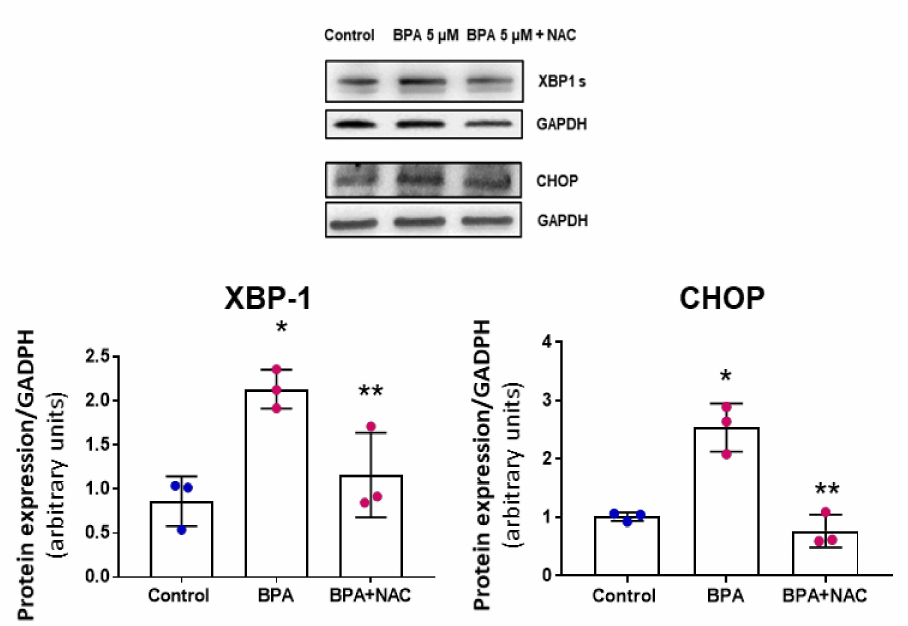
Figure 6. NAC prevents early UPR activation induced by BPA treatment in MAEC. A. Western blotting analysis of MAEC treated with 5 µ M BPA and BPA 5 µ M + NAC 5 mM for 24 h using antibodies against XBP1 and CHOP. There was a significant increase in XBP-1 and CHOP, which could be avoided by co-treatment with NAC. Results represented are means ± SD. (n = 3, each performed in duplicate). * p < 0.0001 using Kruskal–Wallis test for the comparison between control and BPA-treated cells ** p < 0.0001 using Kruskal–Wallis test for the comparison between BPA and BPA +